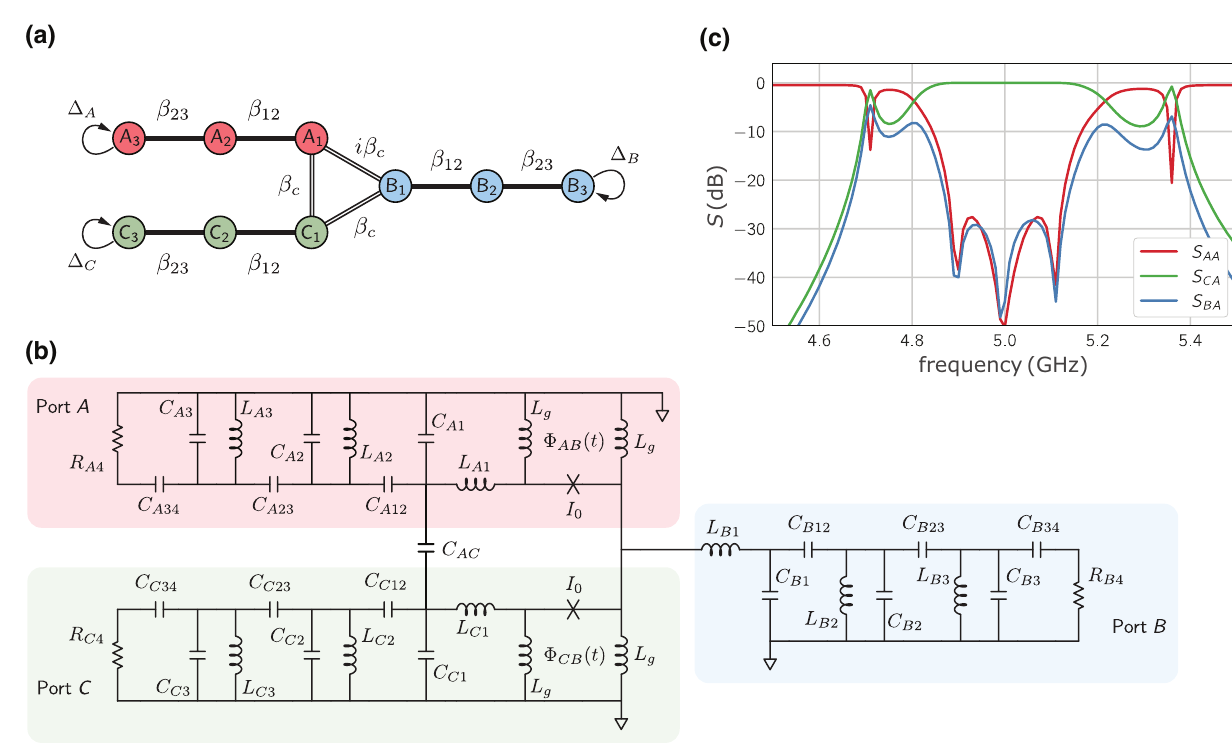
FIG. 19. (a) Coupled-mode graph of a matched parametric circulator. (b) Circuit implementation of a Josephson parametric circula- tor with ports A and C operating at 5 GHz, and port B operating at 7 GHz. Component values are given in Table I. (c) S parameters from harmonic-balance simulation. Here S AA (red) is the reflection from port A , and S CA (green) and S BA (blue) are forward and reverse transmissions, respectively.